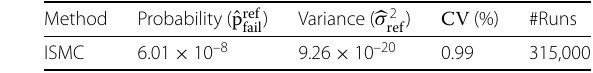
Table 7 Memory cell: reference probability estimation